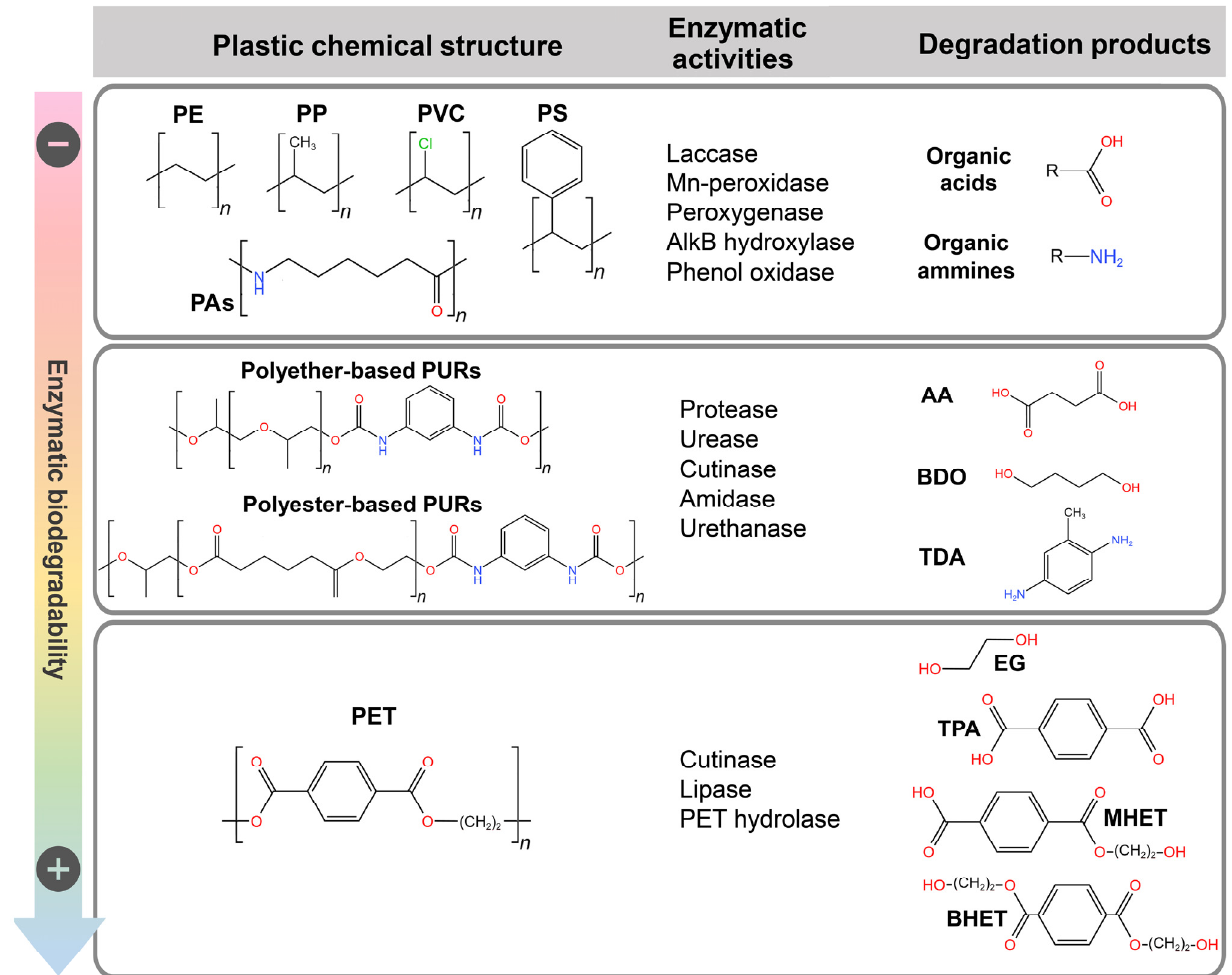
Figure 5. The main classes of enzymes involved in the degradation of different types of traditional petroleum-based plastics in order of their biodegradability to summarize what was reported in the